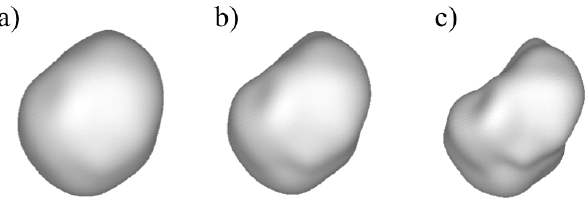
Fig. 5. Gaussian random spheres ( D = 50µm) with (a) σ = 0 . 069, (b) σ = 0 . 110, and (c) σ = 0 . 179. The corresponding area ratios are (a) 0.85, (b) 0.77, and (c) 0.69.